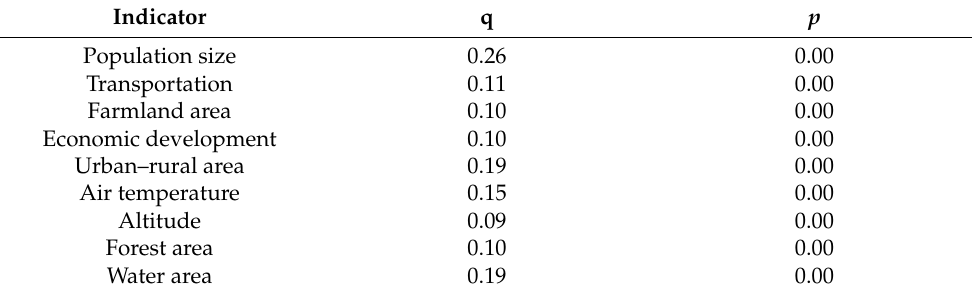
Table 3. Results of single factor